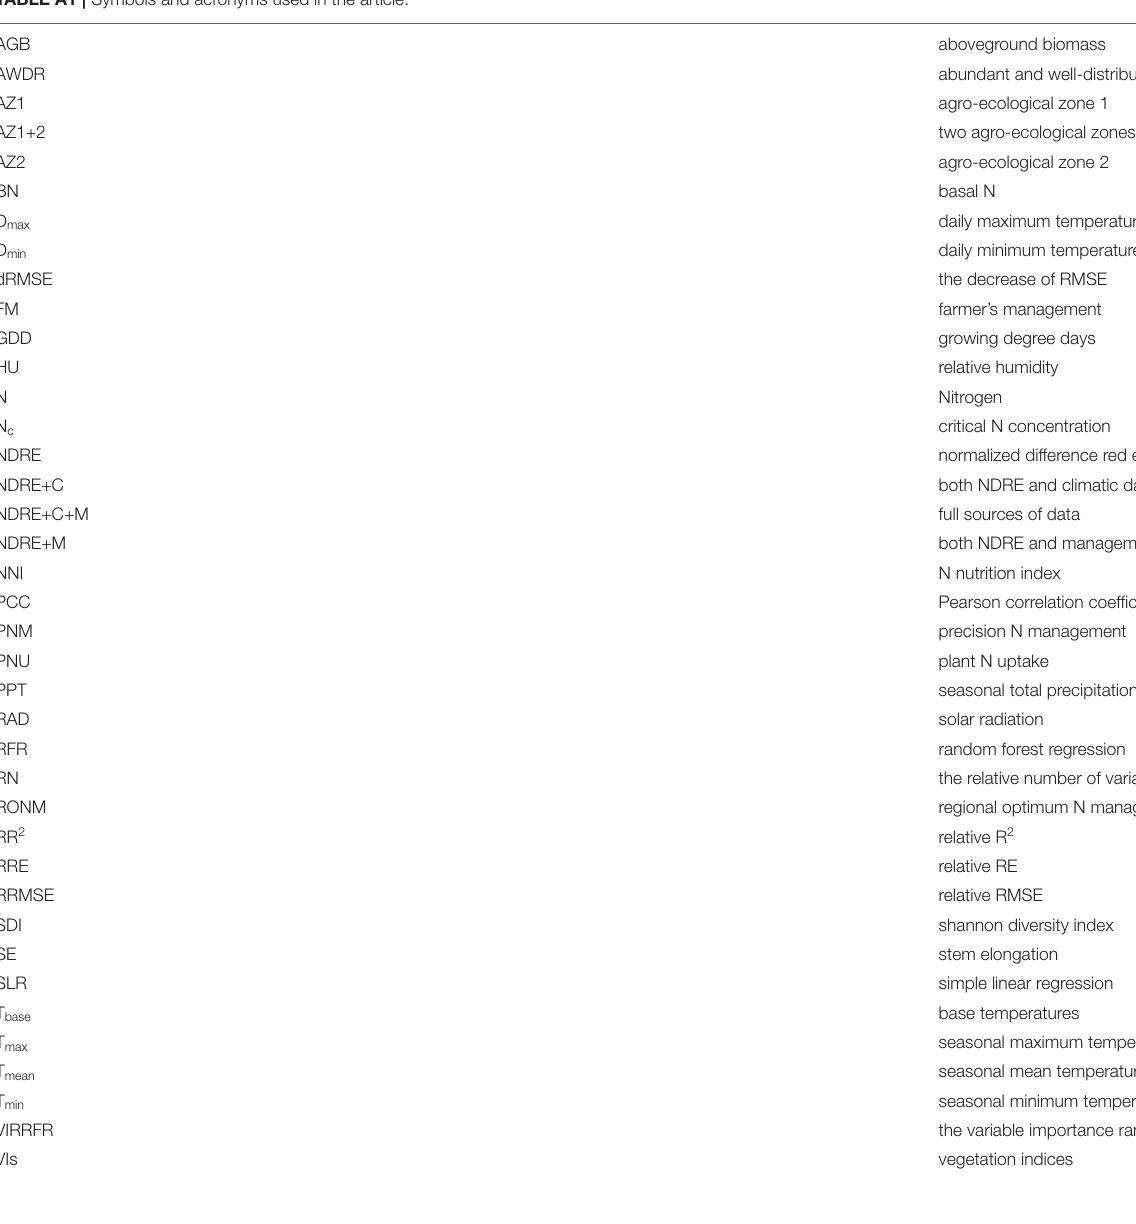
TABLE A1 | Symbols and acronyms used in the